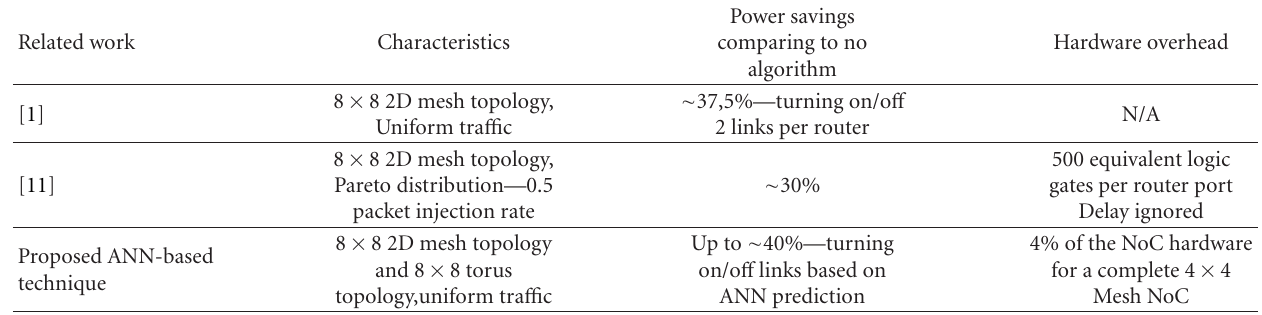
Table 1: Power savings/hardware overhead